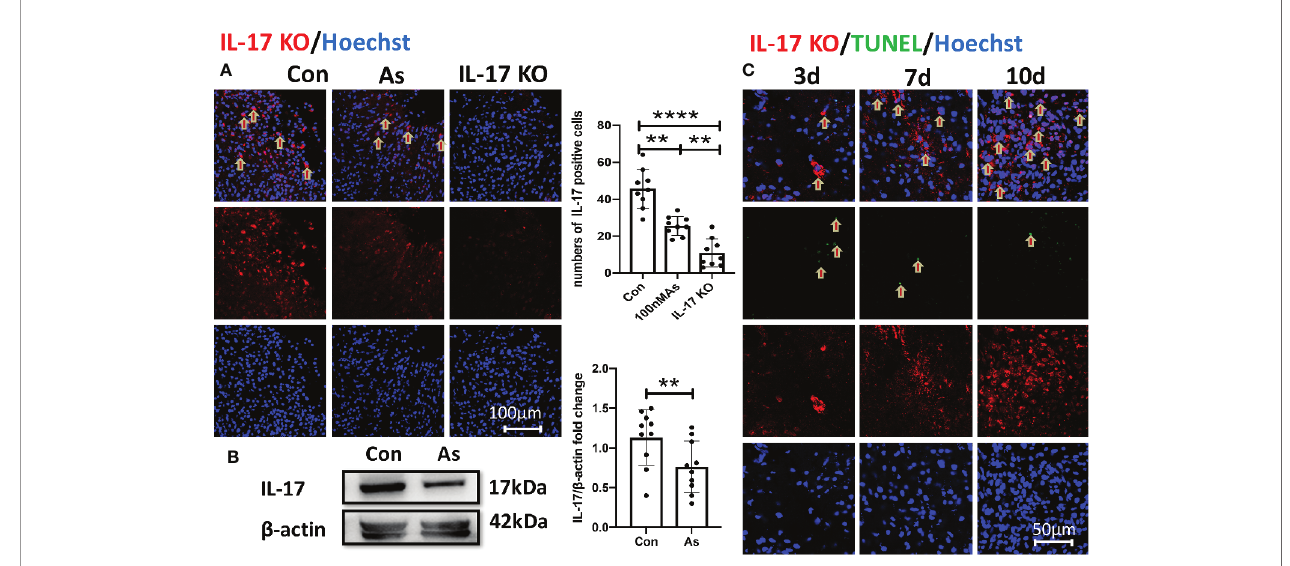
FIGURE 3 | The overexpression of IL-17 after stroke is reversed by As IV. (A) Immunostaining for IL-17 in the infarct at 10dpi. Notice signi fi cantly decreased numbers of IL-17-positive cells of mice in the As IV and IL-17 KO groups compared with the control group. n = 3, **p < 0.01, ****p < 0.0001. (B) Western-blotting for IL-17 in ipsilateral hippocampus on 7dpi after stroke. Notice the signi fi cant downregulation of IL-17 by administering As IV. n = 3, **p < 0.01. (C) Immunohistochemistry for IL-17 and TUNEL staining in the infarct brain region of mice at different time after stroke. Notably, the expression of IL-17 increased gradually and slowly after stroke and lagged far behind the appearance of apoptosis. IL, interleukin; KO, knockout; TUNEL, TdTmediated dUTP nick end labeling; As, Astragaloside IV; Con,